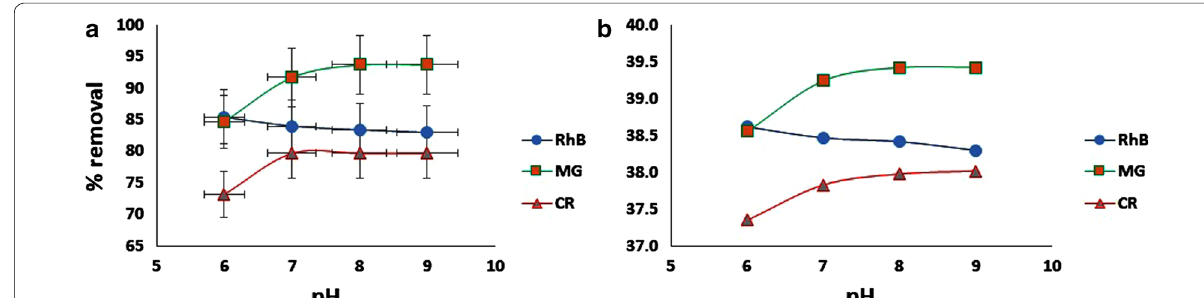
Fig. 3 Effect of pH on removal of MG, RhB and CR based on Mean ( a ) and S/N ( b )